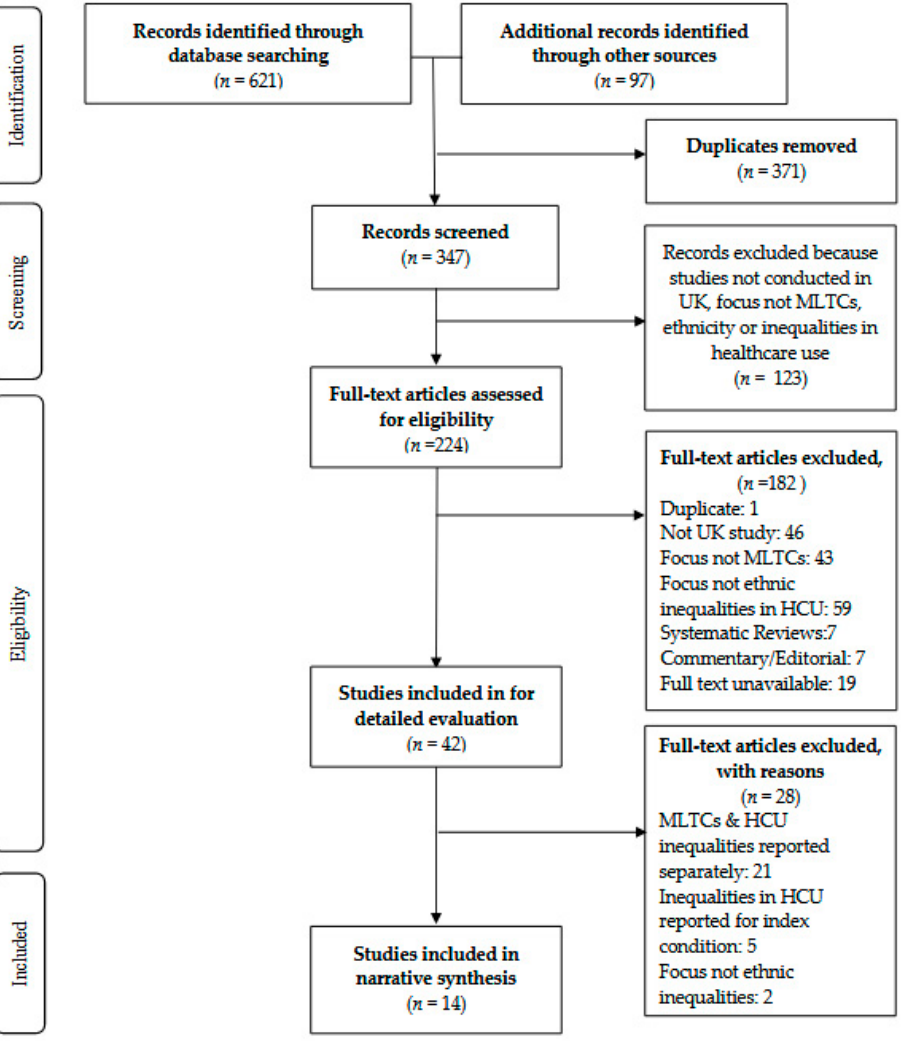
Figure 1. PRISMA flowchart